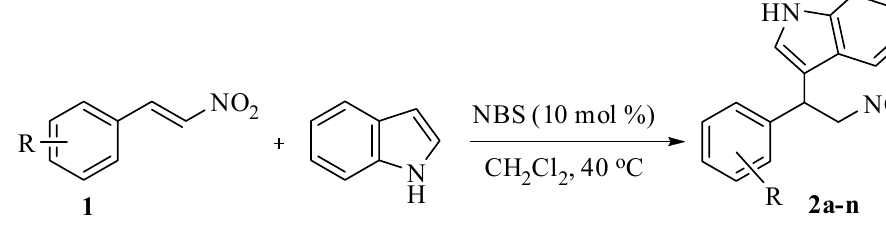
Scheme 2. Reaction of indole with various nitroalkenes catalyzed by NBS.